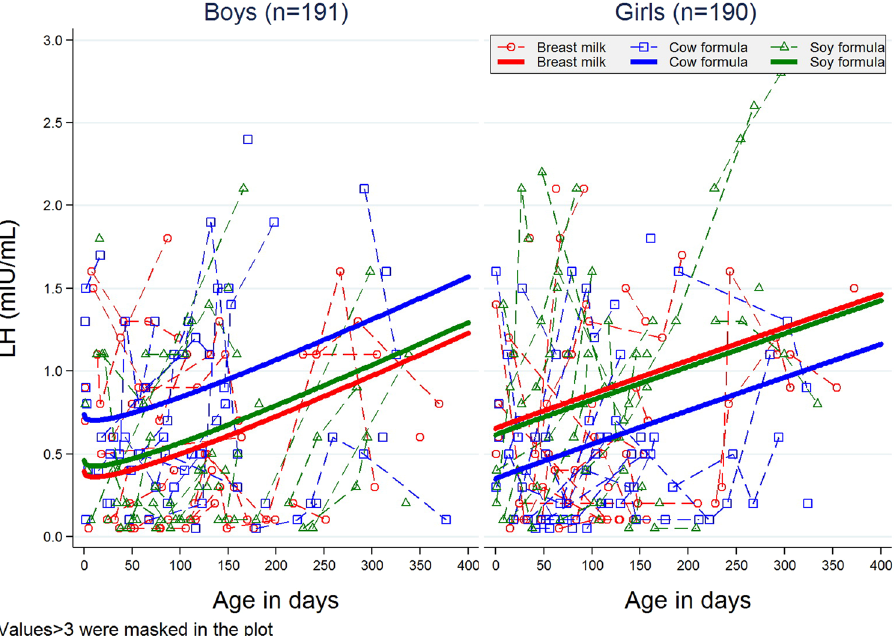
Figure 2. Urinary LH concentration (mIU/mL) as a function of age (d). Plotted points are individual sample values, and those connected by line segments represent multiple visits by the same infant. Plotted nonlinear trajectories were fitted using generalized mixed model for log transformed individual sample